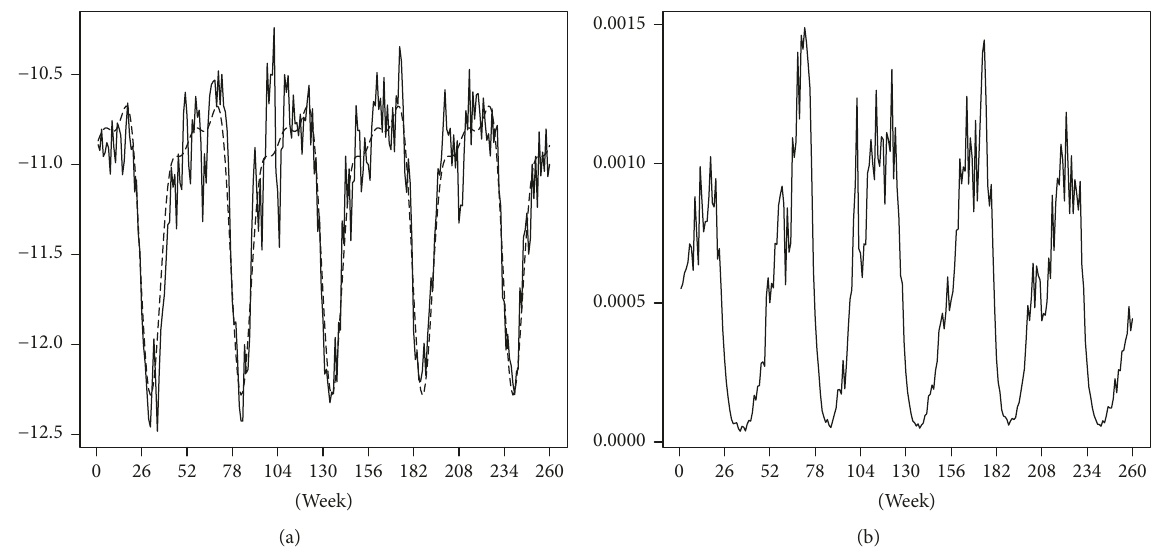
Figure 4: Estimated transmission rate together with its seasonal component (a) and estimated probability of getting the virus (b) from week 2, 2007, to week 1, 2012.